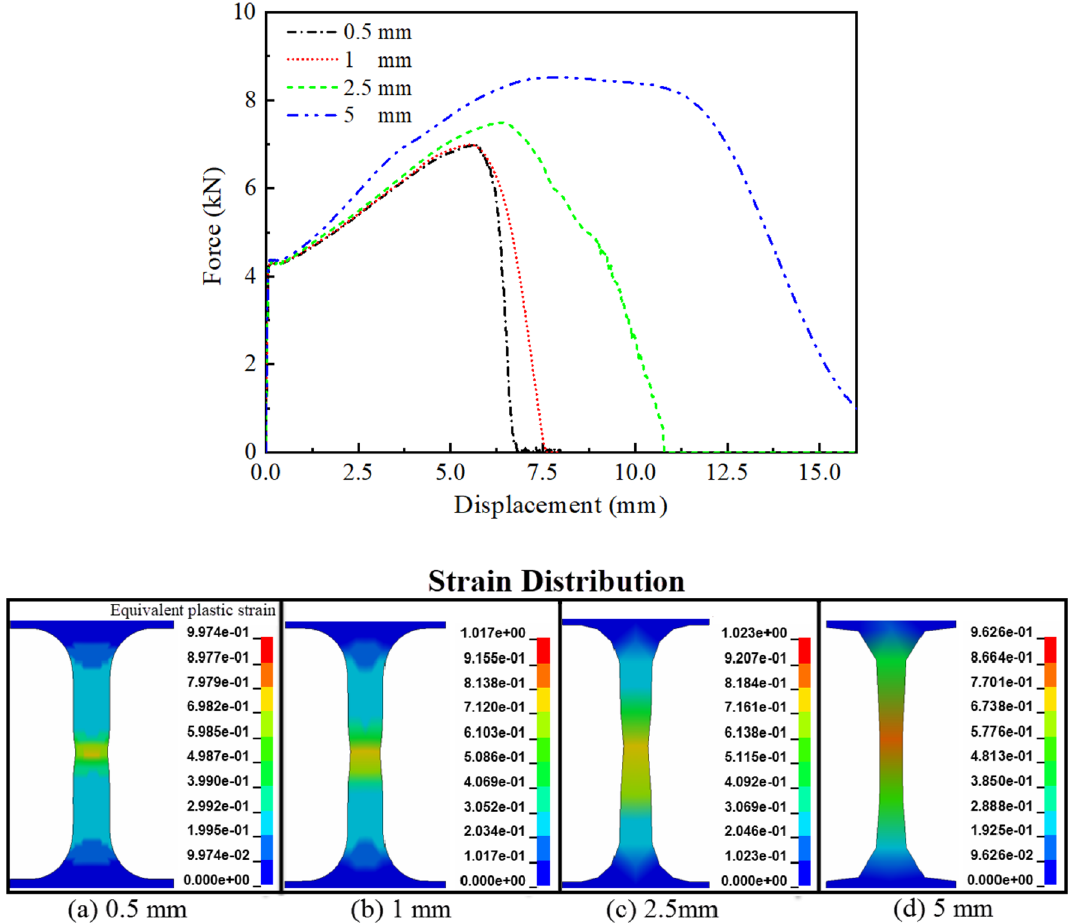
Figure 12 Force-displacement curves and equivalent strain distributions for different mesh sizes